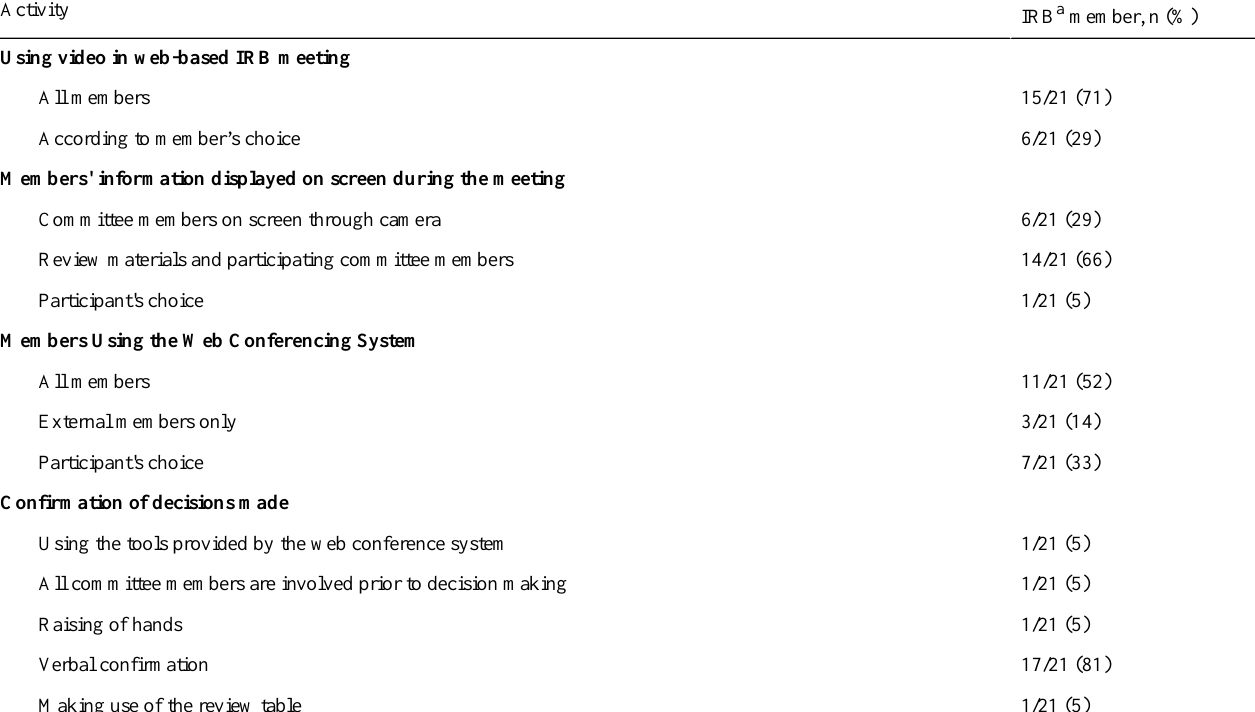
Table 3. Influence of the introduction of web conference systems for institutional review board meetings on the review process.